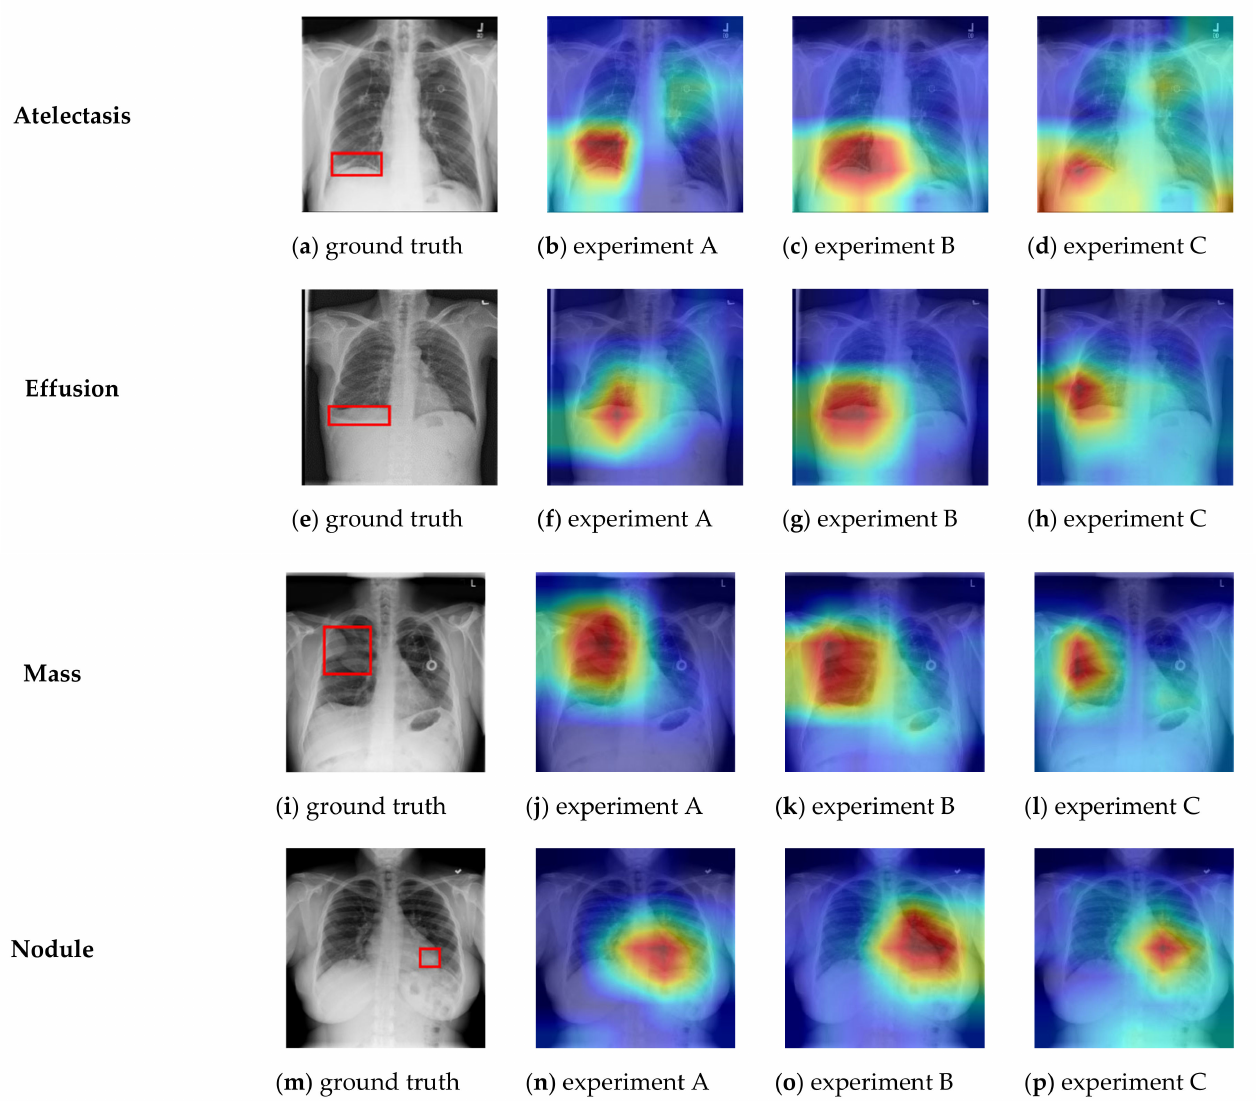
Figure 8. Ground truth comparison localization vs. Grad-CAM visualized predicted location for tested network